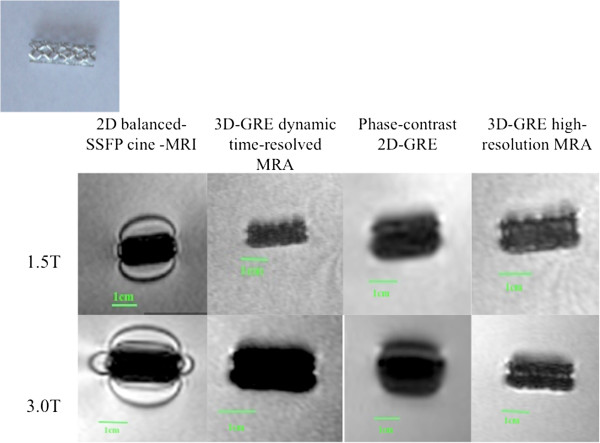
MR appearance of Palmaz Genesis Transhepatic Biliary stent (Device 1,2).